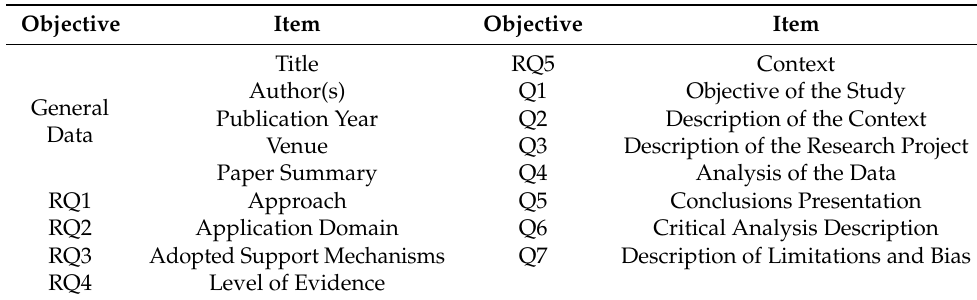
Table 4. Summary of items extracted from each study including research questions and quality